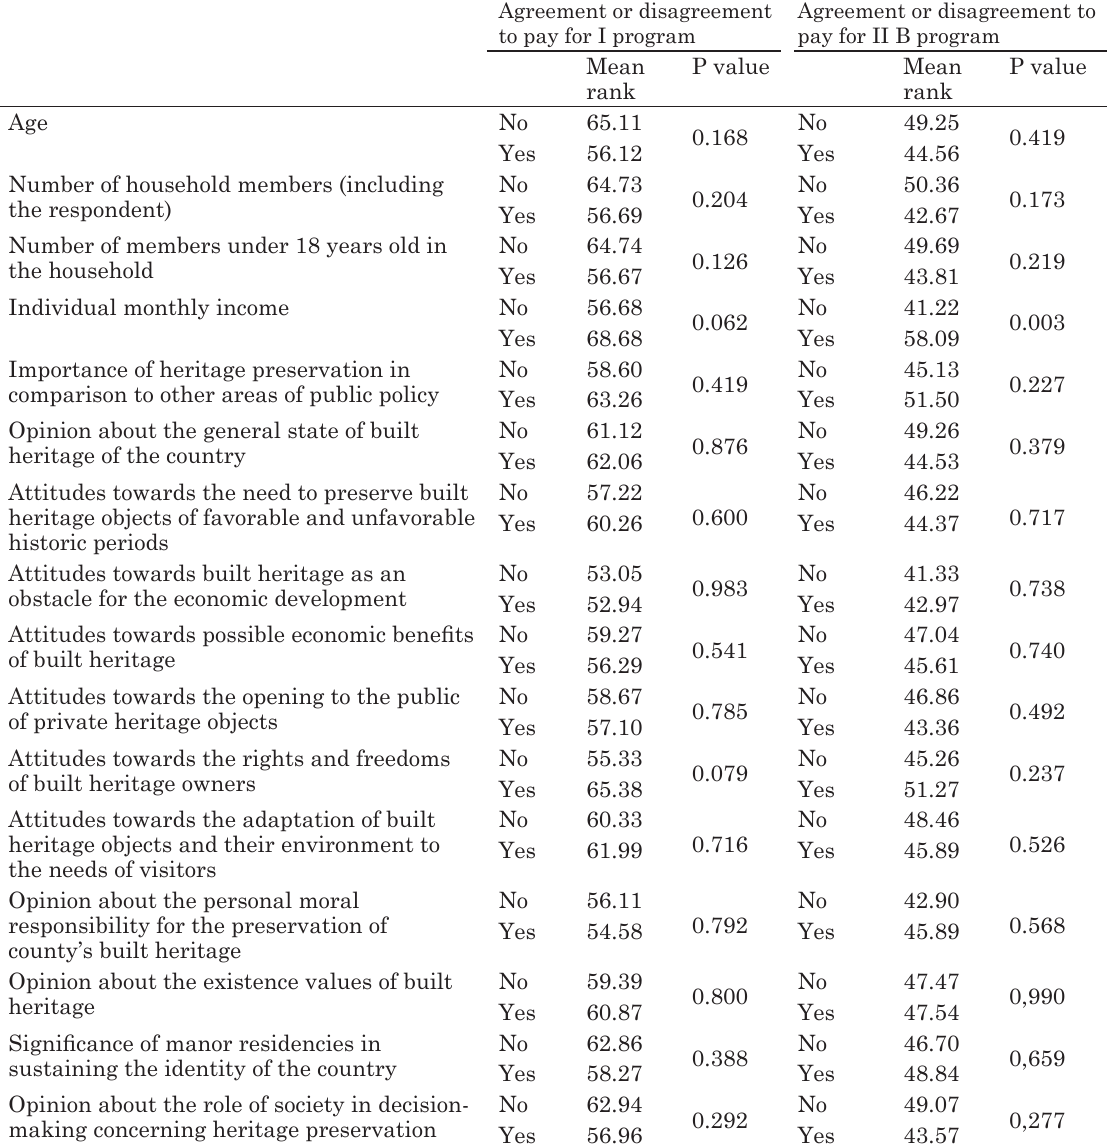
table 1. results of mann-Whitney test for I and II B program